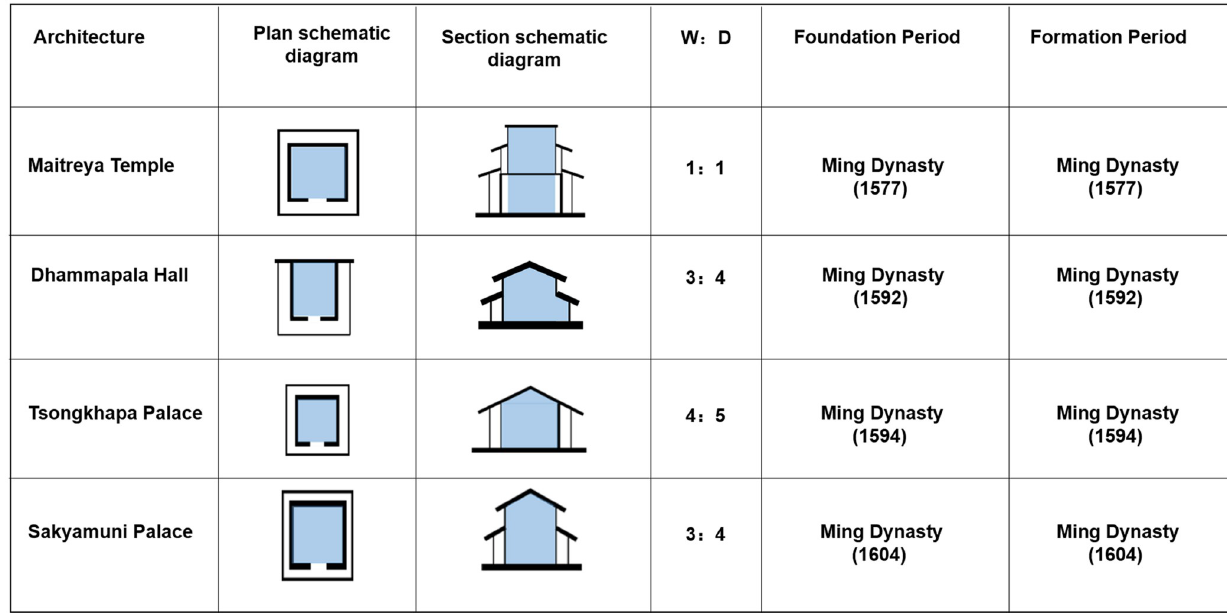
Fig 6. Spatial features of the palace buildings of type I. (W, width of the Palace Halls; D, depth of the Palace Halls).